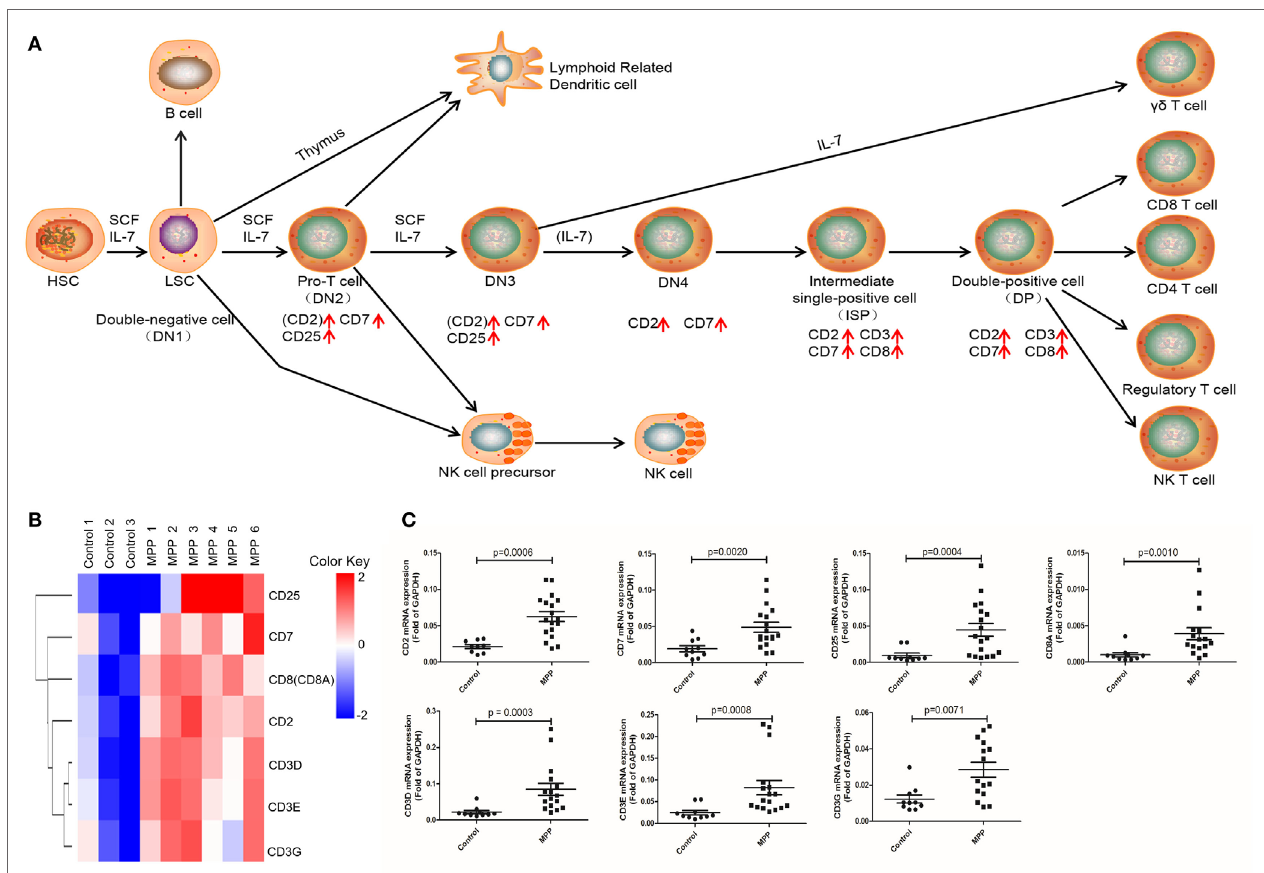
FigUre 4 | Differential expression genes (DEGs) mapped to hematopoietic cell lineage Kyoto encyclopedia of genes and genomes pathway. (a) Model diagram shows hematopoietic cell lineage pathway, red arrows indicate upregulated gene expression. (B) Cluster analysis of DEGs that mapped to hematopoietic cell lineage pathway. (c) Quantitative real-time PCR validation of DEGs mapped to hematopoietic cell lineage